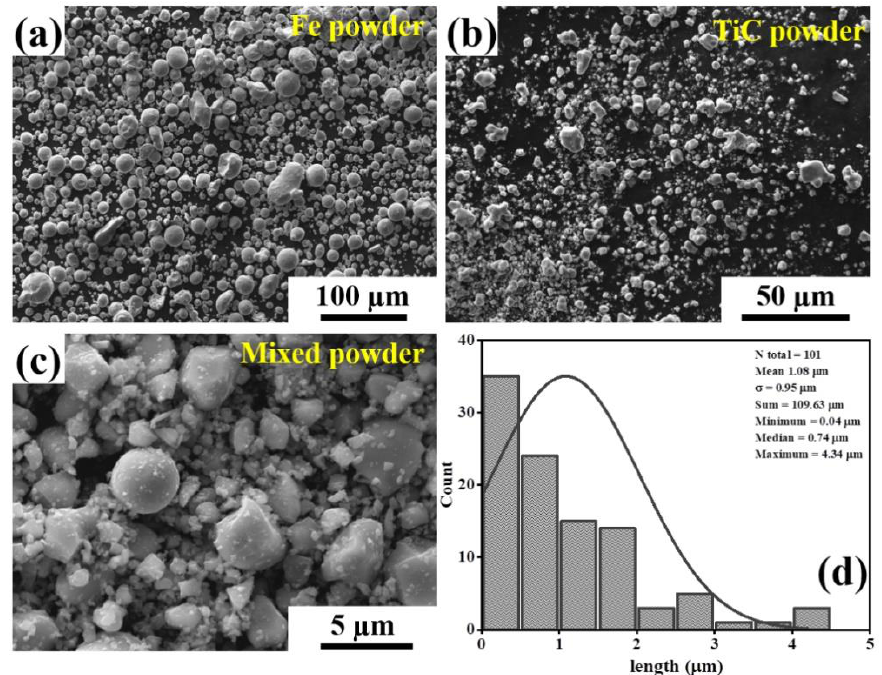
Figure 1. Scanning electron microscopy images of the initial powders ( a ) Fe powder; ( b ) TiC powder; ( c ) mechanically mixed powder; and ( d ) particle size distribution of the mixed powder.